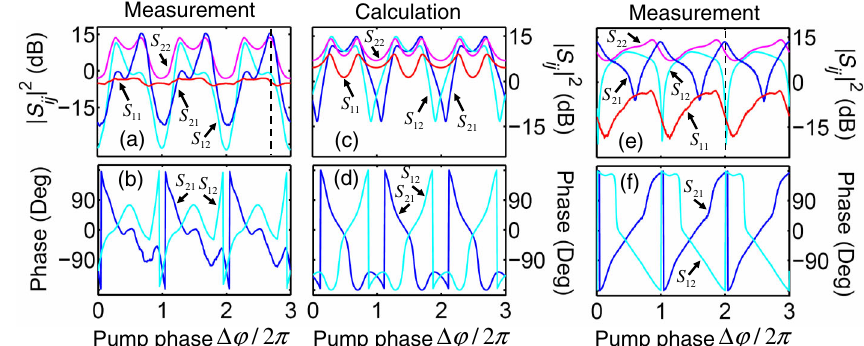
/ 2 ϕ π∆ ¼ 23 : 42 GHz . The vertical dashed P